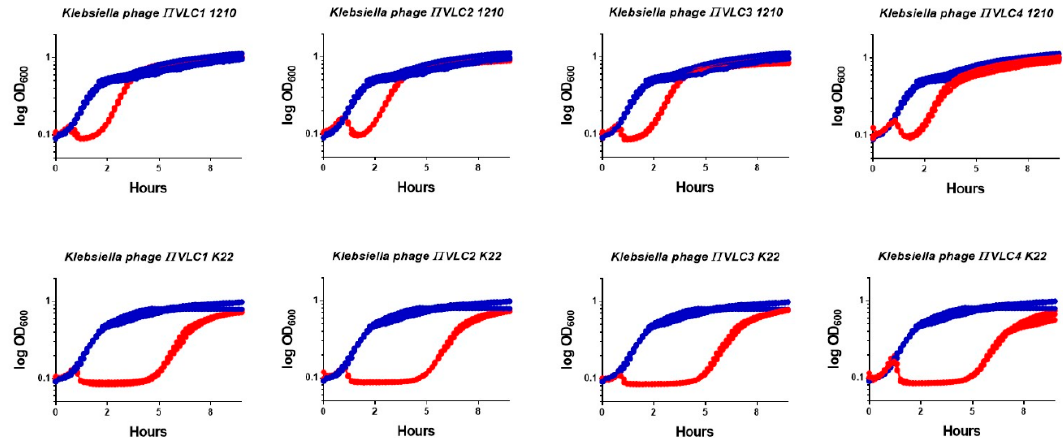
Figure 2. Lysis assays. Optical density of cultures of K. pneumoniae belonging to isolate 1210 (top) or the K. pneumoniae K22 reference strain (bottom). Cultures were inoculated with 10 5 PFU. Red: three replicate assays with phage. Blue: three replicate assays of non-infected control.